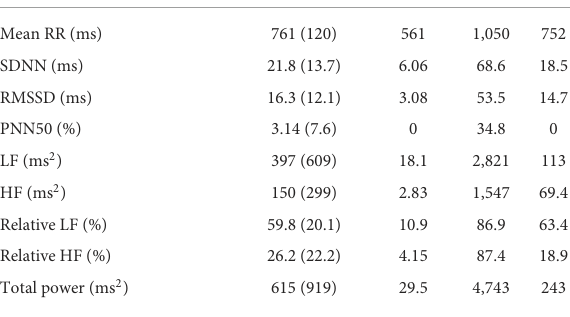
TABLE 3 Cardiologic baseline measures.